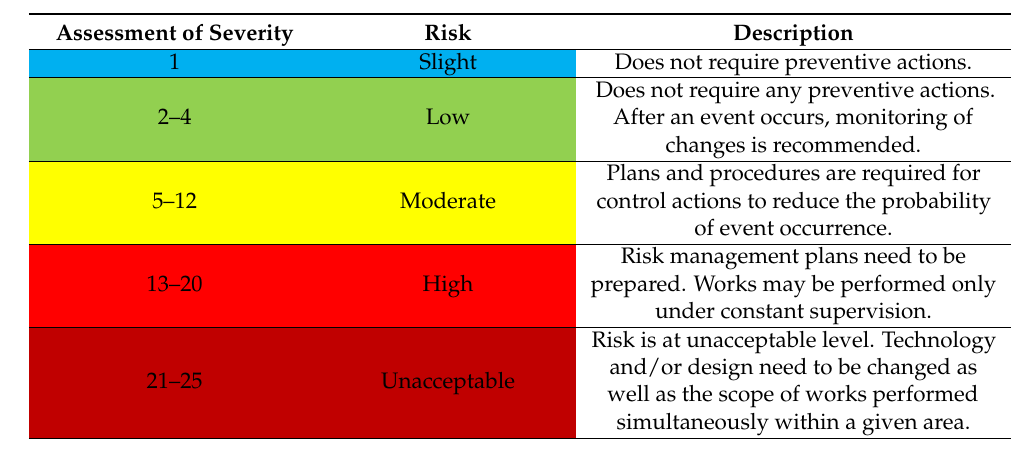
Table 5. Risks in construction